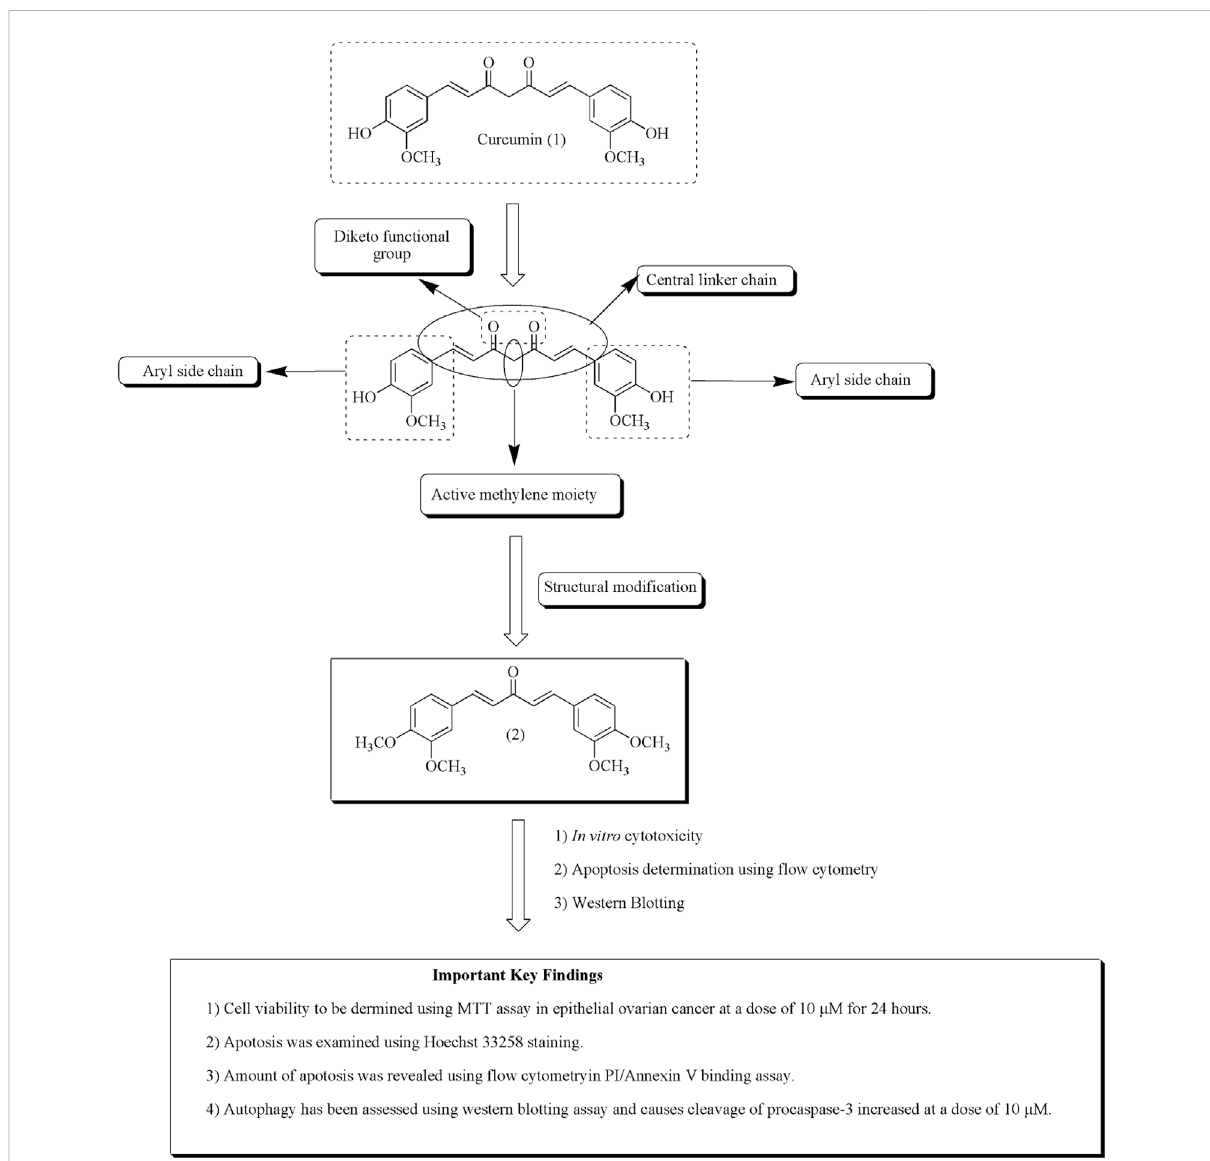
FIGURE 5 Structure – activityrelationshipsofcurcuminalongwithmechanisticinsights.Anti-ovariancancerpotentialofcurcuminanalog(2)wasvalidated through MTT assay, Hoechst staining, fl ow cytometry, and Western blotting